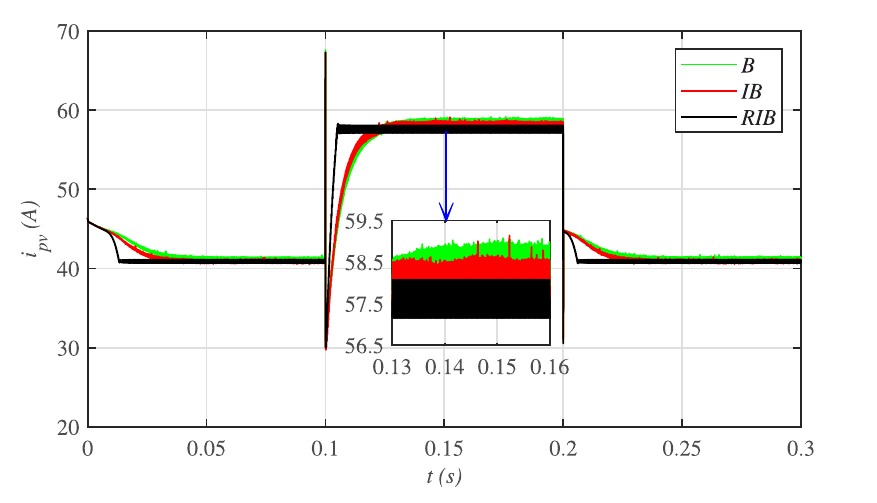
Fig 11. PV array comparative currents under case